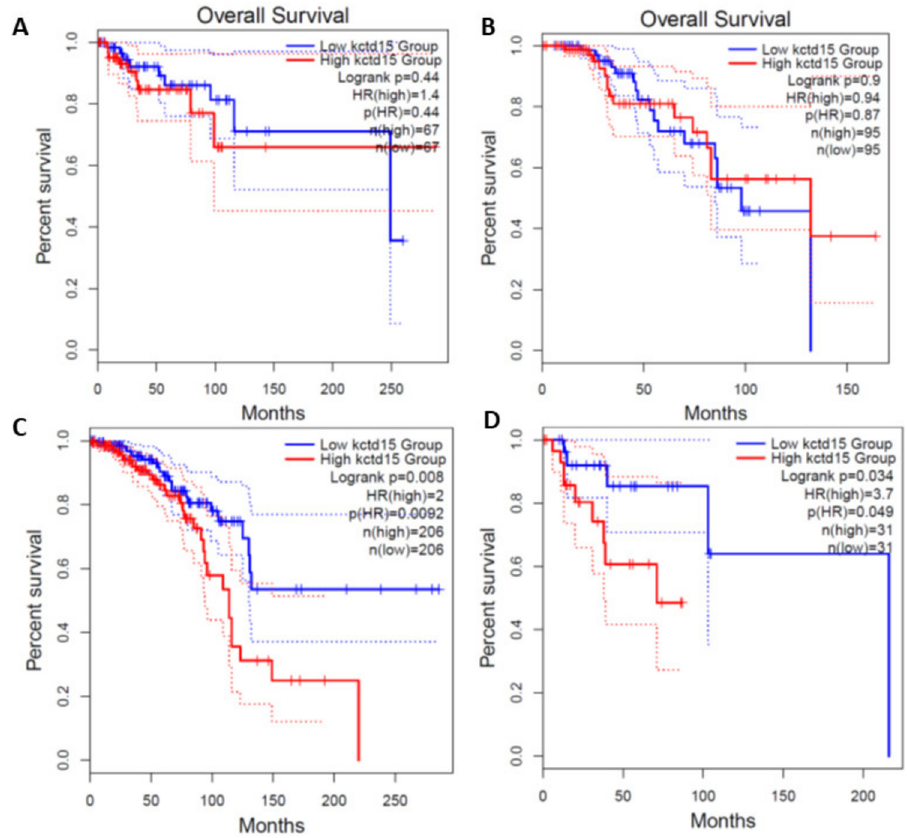
Figure 8. KCTD15 mRNA predicts worst survival in breast cancer subtypes. Kaplan–Meier plots generated from GEPIA show Overall Survival in breast cancer subtypes with high and low levels